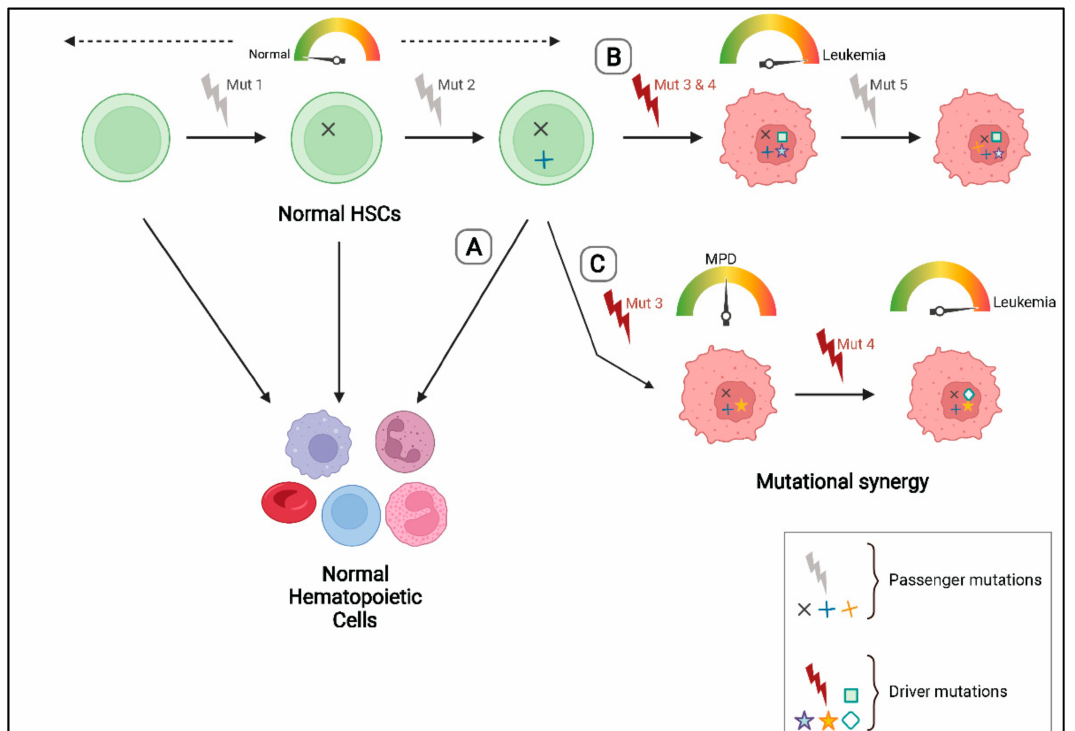
Figure 1. Driver v/s passenger mutations: A normal hematopoietic stem cell (HSC) might acquire passenger mutations that do not impact the growth, proliferation potential or fitness of the cell. ( A ) If a passenger mutation is acquired in the absence of disease-causing driver mutations, the HSC functions normally and can give rise to normal hematopoietic cells of all lineages. ( B ) On the other hand, acquisition of leukemia driver mutations can lead to malignant transformation of the HSC and leukemia development. ( C ) Data from murine models has shown that the introduction of a single strong leukemia driver mutation (e.g., FLT3 or NPM1 mutation) often leads to myeloproliferative disorders (MPD) but is not sufficient to lead to AML. The co-operation of other driver mutations is required to initiate